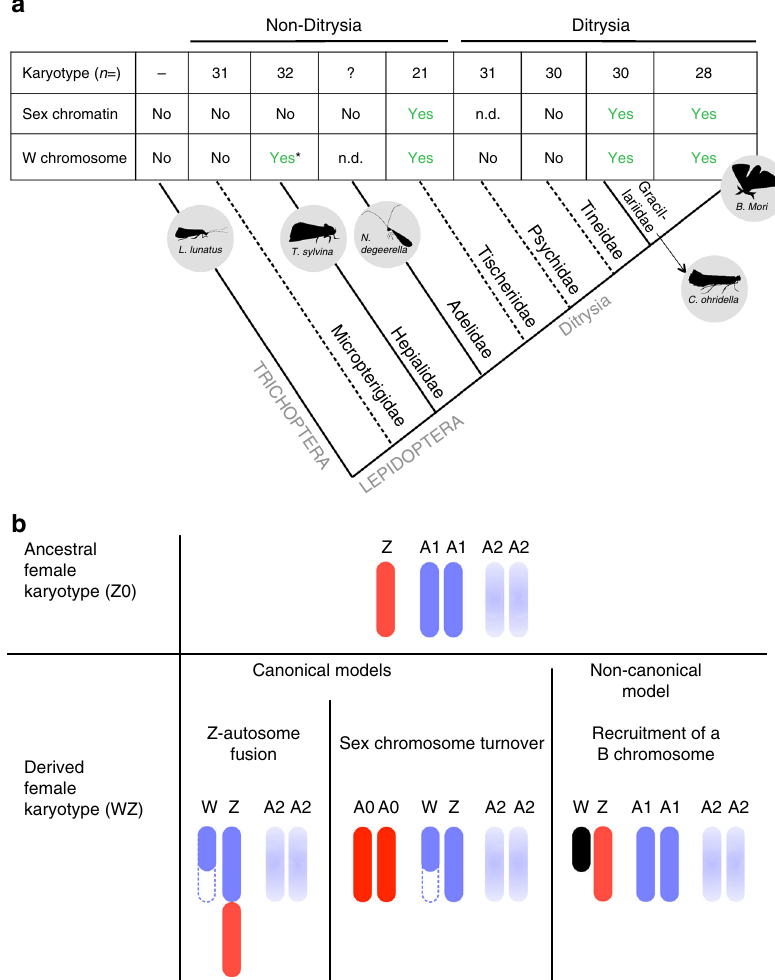
Fig. 1 Evidence and models for the secondary origin of the W chromosome. a Presence/absence of the W chromosome across a simpli fi ed phylogeny of Lepidoptera. The table shows, for each family, the total number of chromosomes; the presence (yes), absence (no) or non-determination (n.d.) of sex chromatin; as well as the cytogenetic con fi rmation of the presence of the W chromosome (adapted from Dalíková et al. 15). In Hepialidae, only some species, which did not include T. sylvina , were cytogenetically investigated to assess the presence/absence of the W (asterisk). Dotted lines represent families that are not investigated in our study, while gray circles show the fi ve studied species. b Hypotheses for the secondary acquisition of the W chromosome. The ancestral Z0 female karyotype is represented by the Z chromosome (in red) and two pairs of autosomes (A1 and A2, in blue). In the two canonical models (Z-autosome fusion and sex chromosome turnover), the new sex chromosomes derived from a standard pair of autosomes (A1). In the non-canonical model, the W chromosome has a non-autosomal origin (in black), e.g., the recruitment of a B chromosome. The blue dotted lines represent the secondary degradation of the neo-W